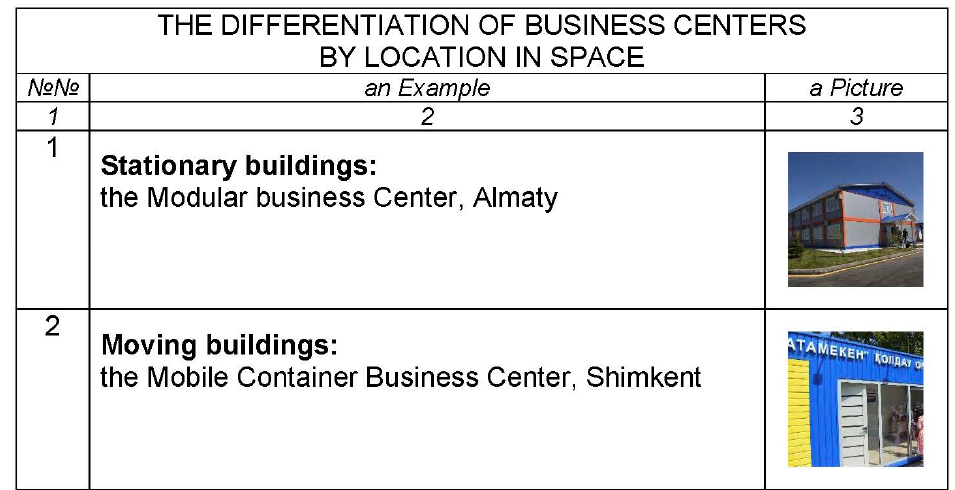
Figure 18. The differentiation of business centers by location in space: ( 1 ) the Modular business Center, Almaty [136]; and ( 2 ) the Mobile Container Business Center, Shymkent [137].